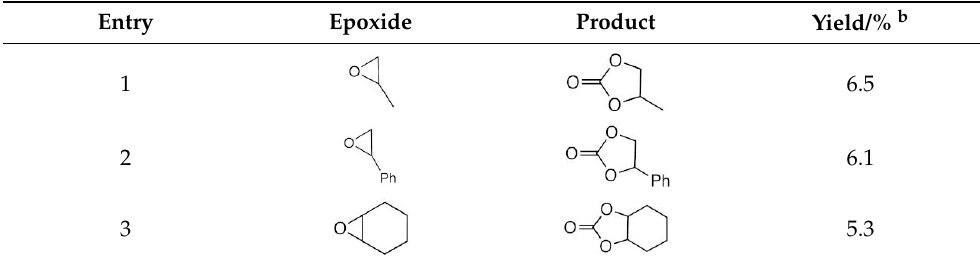
Table 3. Selected data a for the cycloaddition of CO 2 to epoxides catalyzed by [FeCl 2 { κ 3 -HC(pz) 3 }] in THF.